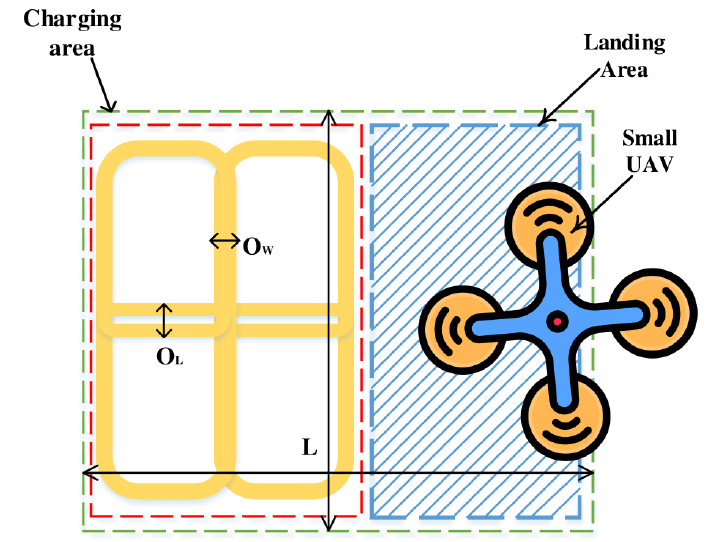
Figure 13. The WPT charging configuration for